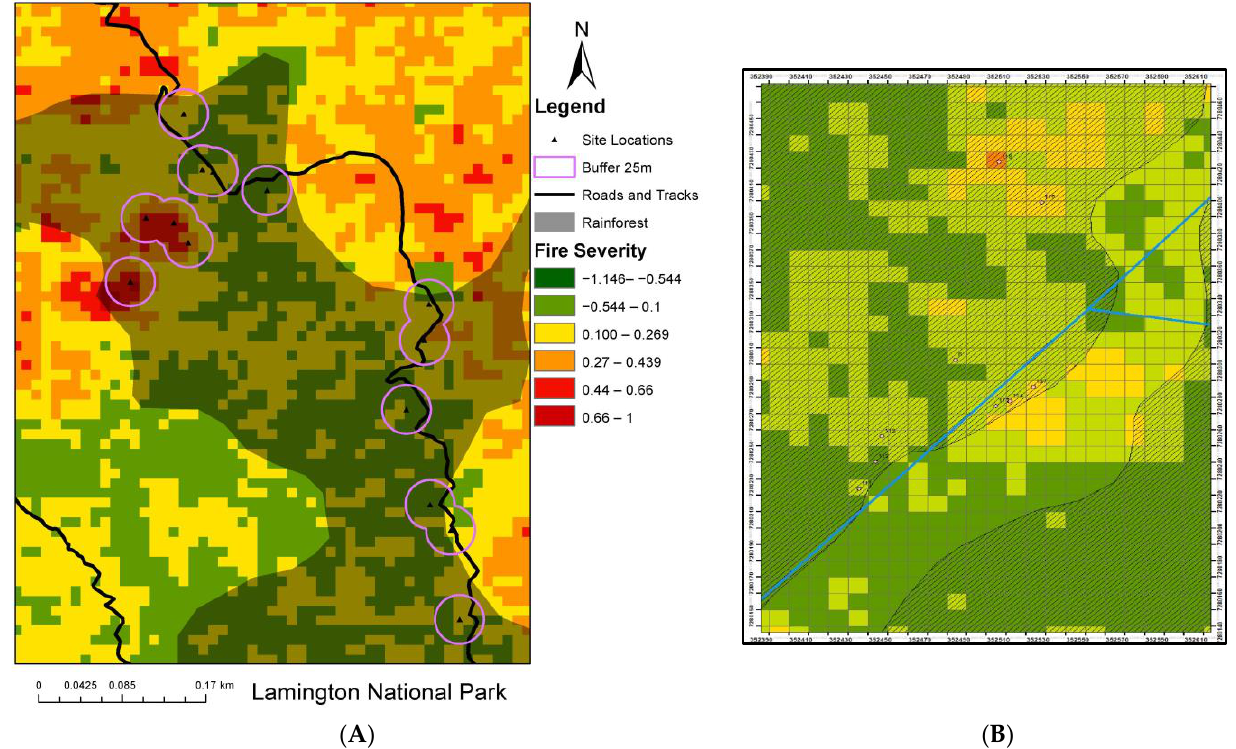
Figure 4. ( A ) Fire-severity mapping displaying site locations, rainforest polygons, roads and tracks data and the interface of areas previously burnt shown as the fire-severity image. ( B ) Fire-severity mapping displaying E/N axis and 10 × 10 m grid lines used to navigate in the field.